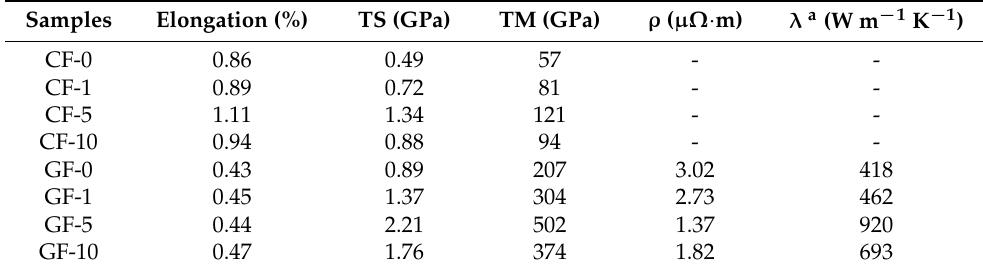
Figure 8. SEM images of different PIM-derived carbonized fibers and graphitized fibers. Table 3. Main Properties of Carbon Fibers.